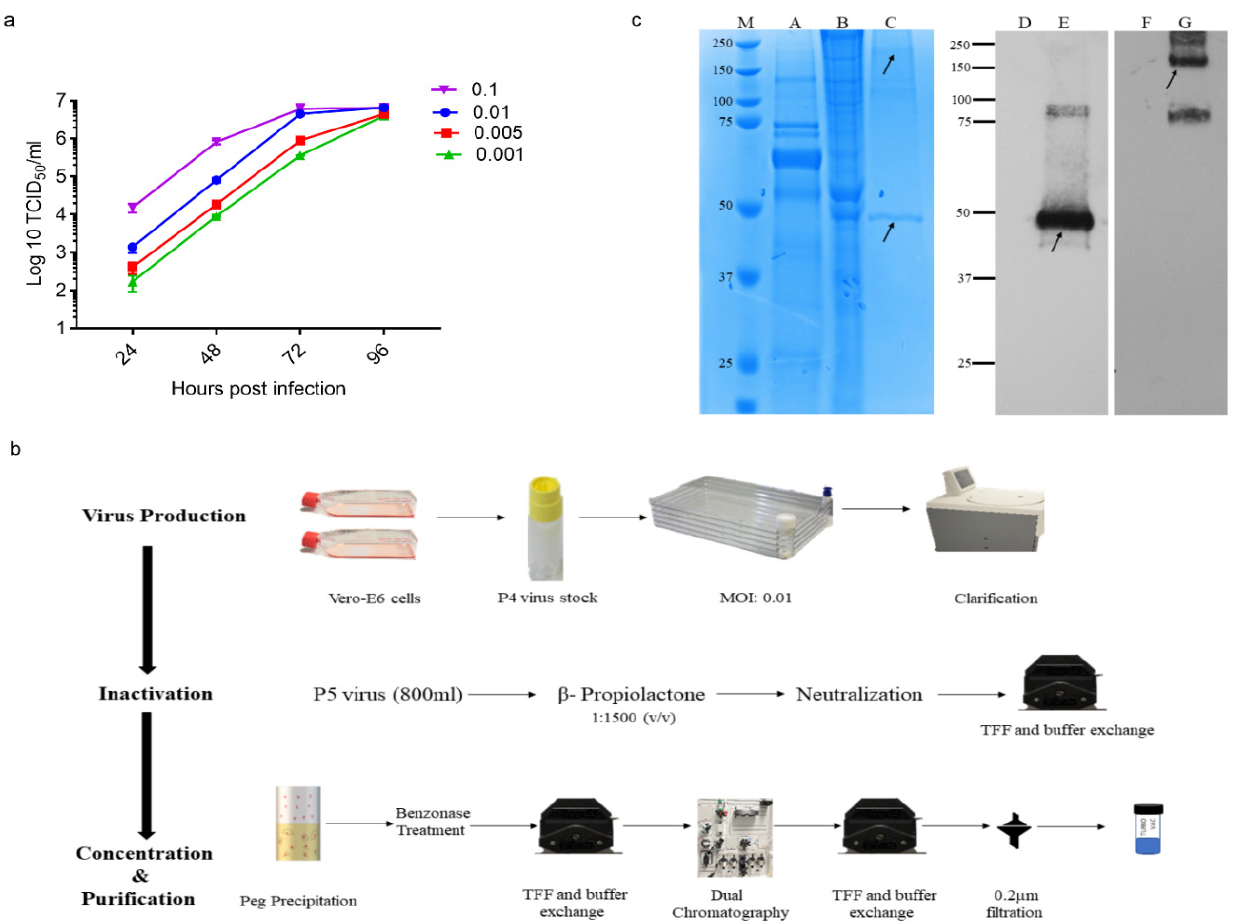
Figure 1. Preparation of ERUCoV-VAC. ( a ) The viral kinetics of the hCoV-19/Turkey/ERAGEM-001/2020 strain at different multiplicities of infection (MOI). ( b ) Flowchart of ERUCoV-VAC preparation. ( c ) Protein profiles of the hCoV-19/Turkey/ERAGEM-001/2020 virus strain before and after purification. Total proteins were separated by Nu-page 10% bis-tris SDS-PAGE gel. Lane 1, protein molecular weight marker (M). Lane A, uninfected Vero E-6 cells as a negative control. Lane B, Vero E-6 cells infected with the hCoV-19/Turkey/ERAGEM-001/2020 virus strain. Lane C, purified hCoV-19/Turkey/ERAGEM-001/2020 virus strain. Western blot analysis of purified hCoV-19/Turkey/ERAGEM-001/2020 virus strain probed with a human antibody to the SARS-CoV-2 nucleocapsid protein (1:2500) (GenScript; HC2003) (Lane E) or a rabbit polyclonal to SARS-CoV-2 spike glycoprotein (lane G). Uninfected cell lysates probed with the SARS-CoV-2 nucleocapsid protein (Lane D) and a rabbit polyclonal to SARS-CoV-2 spike glycoprotein (F) were used as a negative control. The arrows indicate that the bands at approximately 180 kDa and 48 kDa represent spike glycoprotein and nucleocapsid protein,